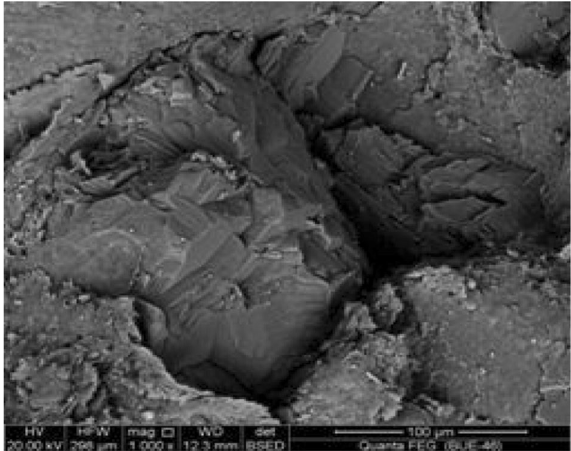
Fig. 6 SEM image ( 9 500)—presence of hairy illites filling pore throats between sand grains (Core #